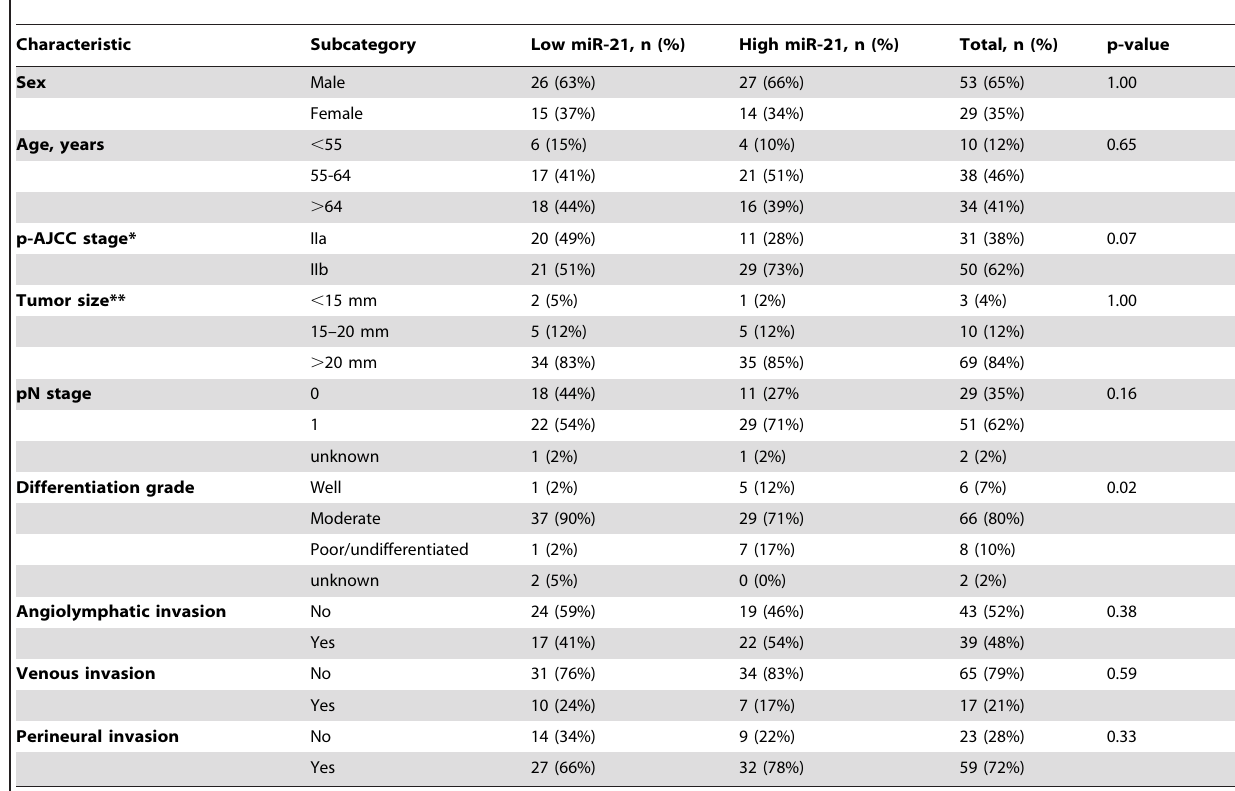
Table 9. Korean cohort: association of miR-21 expression with clinicopathological covariates.